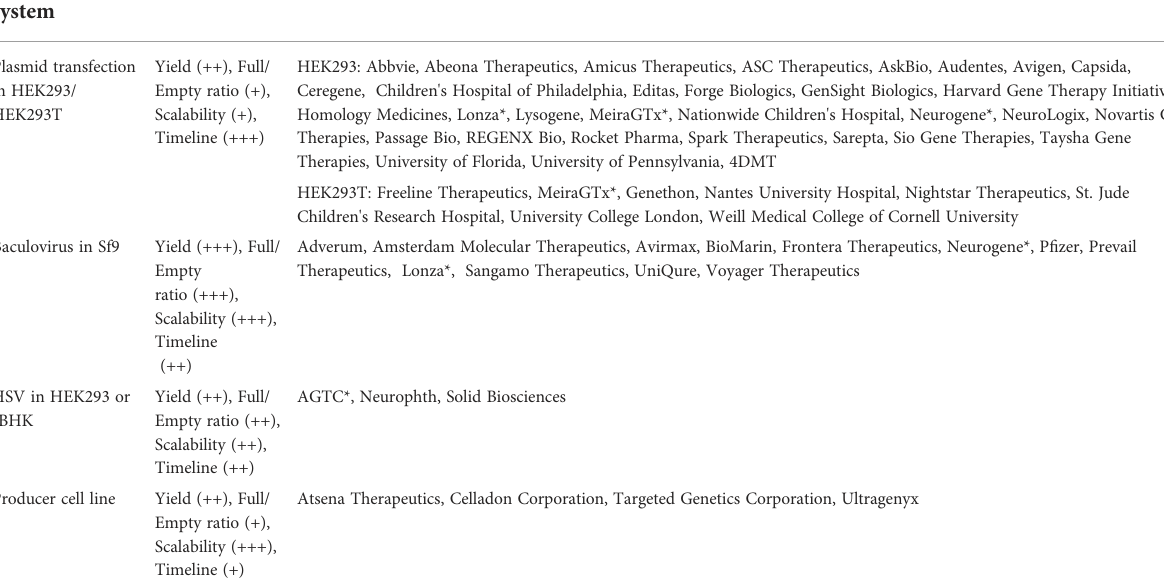
TABLE 3 Comparison of AAV manufacturing